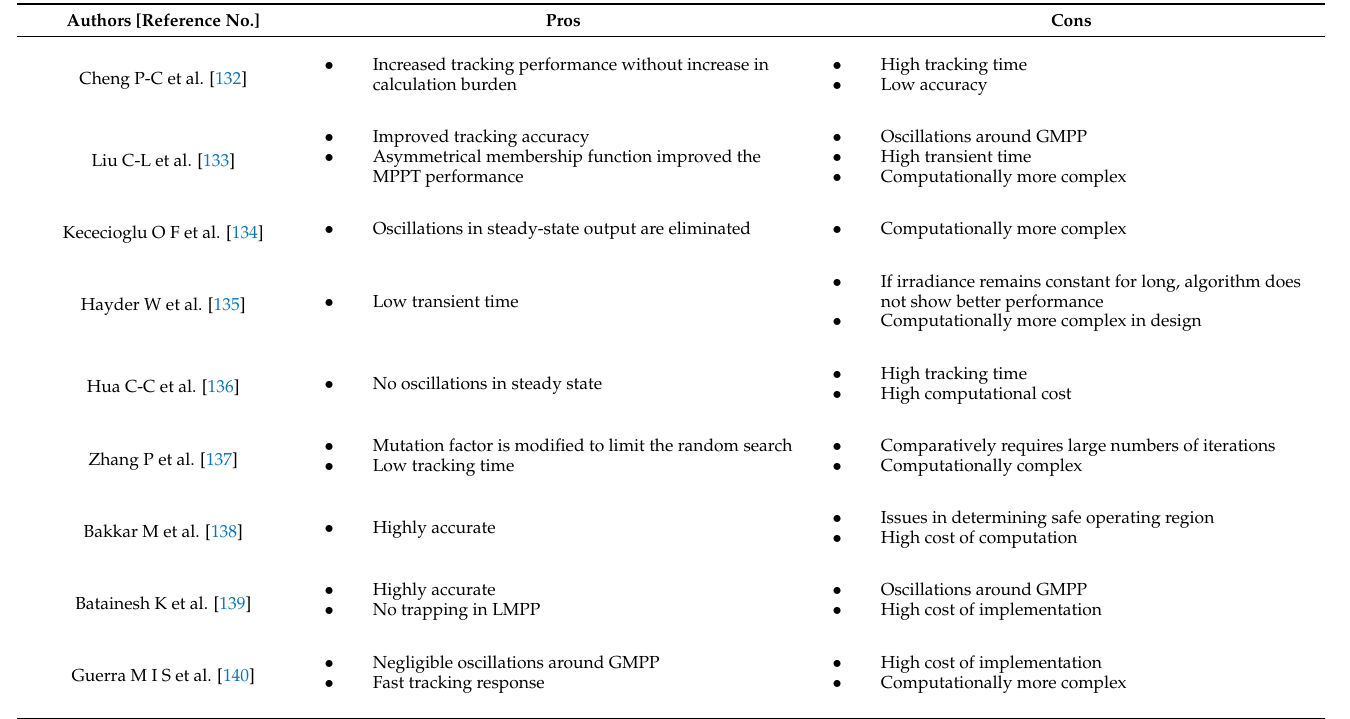
Table 9. Comparative analysis of various MPPT.